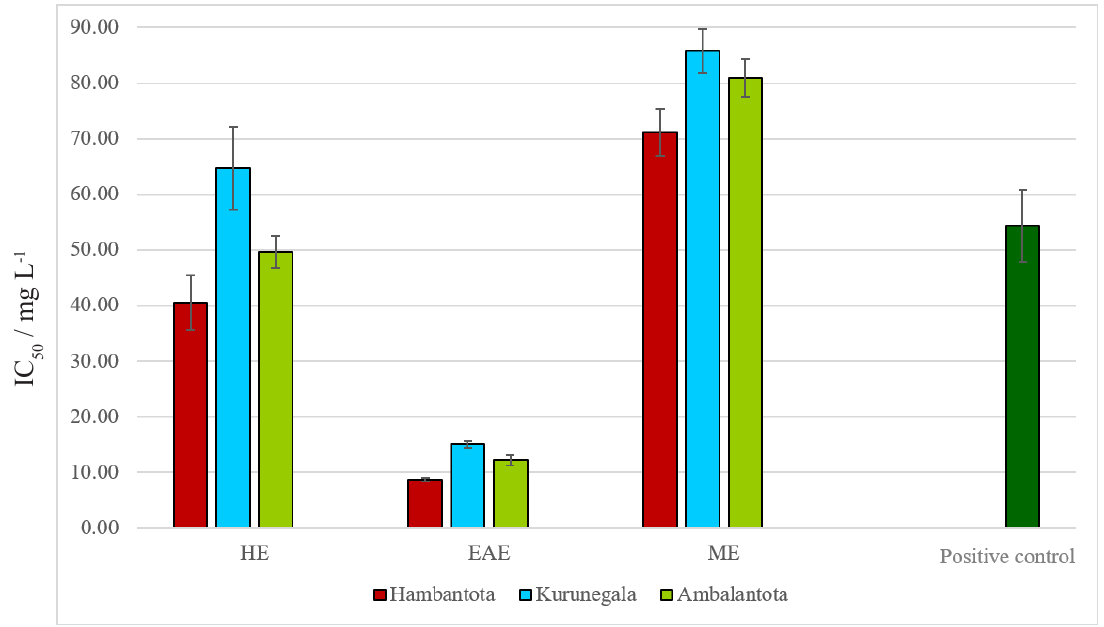
values of brine shrimp 50